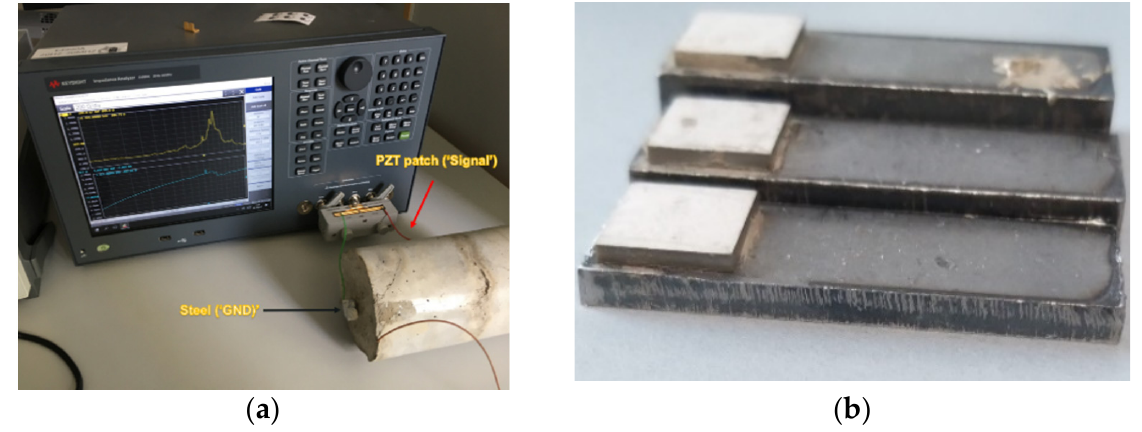
Figure 7. ( a ) Impedance measurement setup for reinforced concrete sample using Keysight E4990A impedance analyzer and ( b ) steel beam with different thickness.